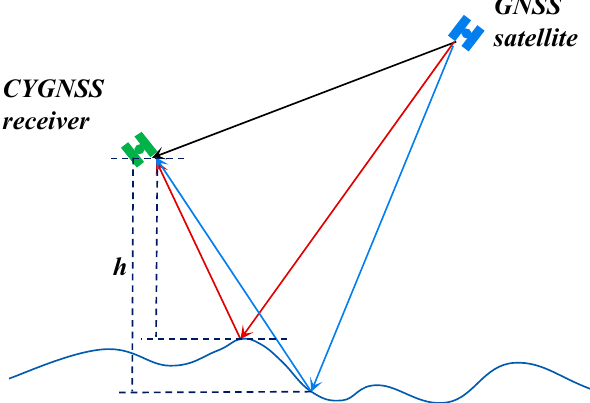
Figure 3. Direct signal and sea surface reflection signal path received by CYGNSS satellite.